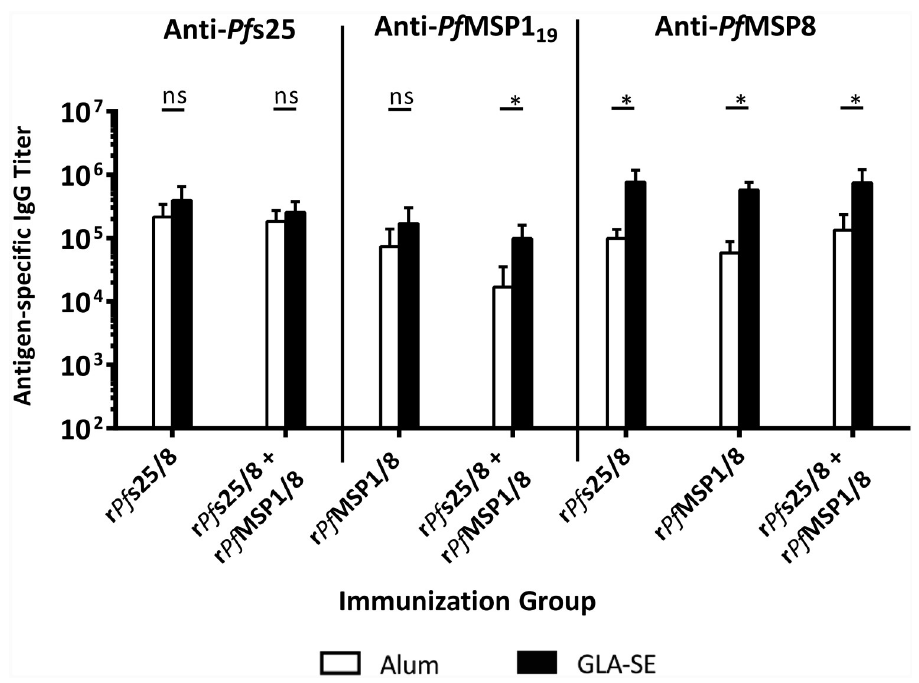
Fig 8. Final antigen-specific IgG titers elicited in monovalent and bivalent vaccine formulations as a function of adjuvant. Titers of antigen-specific IgG following the final subcutaneous immunization were measured for each group via ELISA using plates coated with r Pf s25 or rGST- Pf MSP1 19 (0.25 μ g/well). Graphs depict mean IgG titers +/- standard deviation. To assess the effect of adjuvant on the IgG titer, direct comparisons were made between corresponding antigen groups formulated with either Alum or GLA-SE. Asterisks over horizontal lines indicate significant differences between indicated groups (Mann-Whitney U test; P < 0.05 considered significant; ns, not